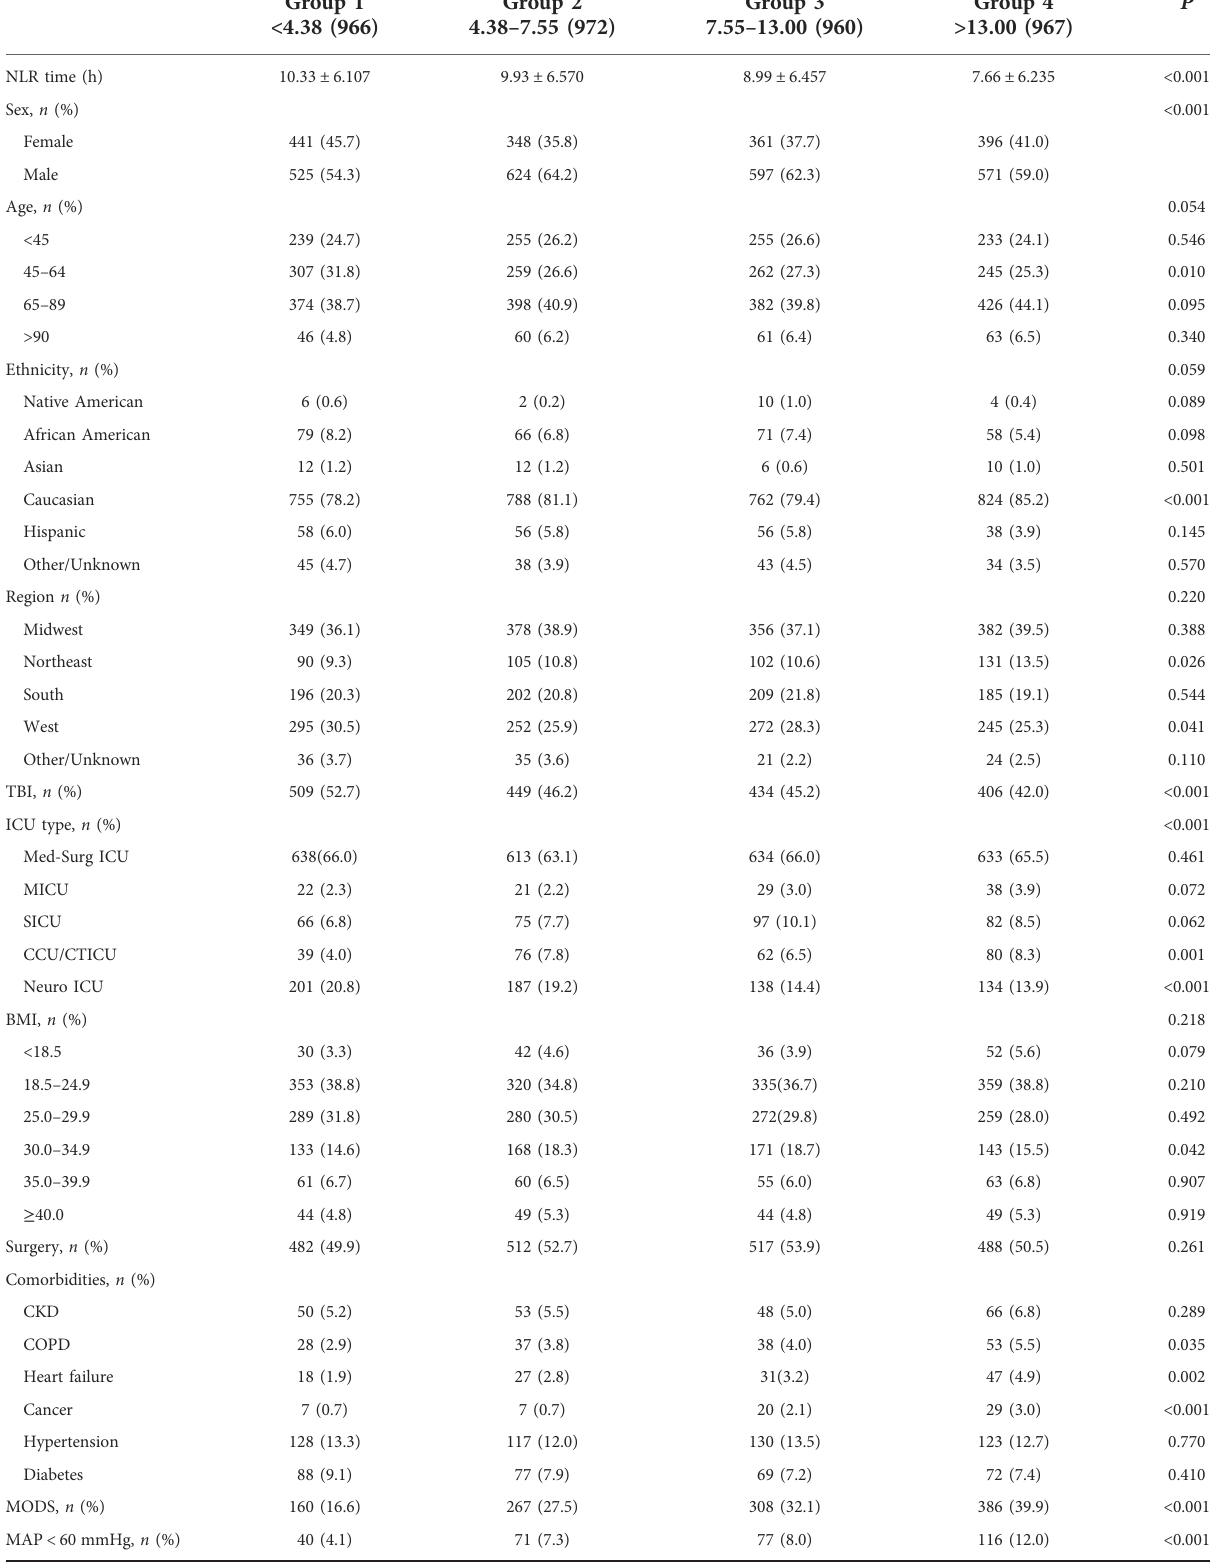
TABLE 1 Univariate analysis of baseline characteristics in 3,865 trauma patients by NLR